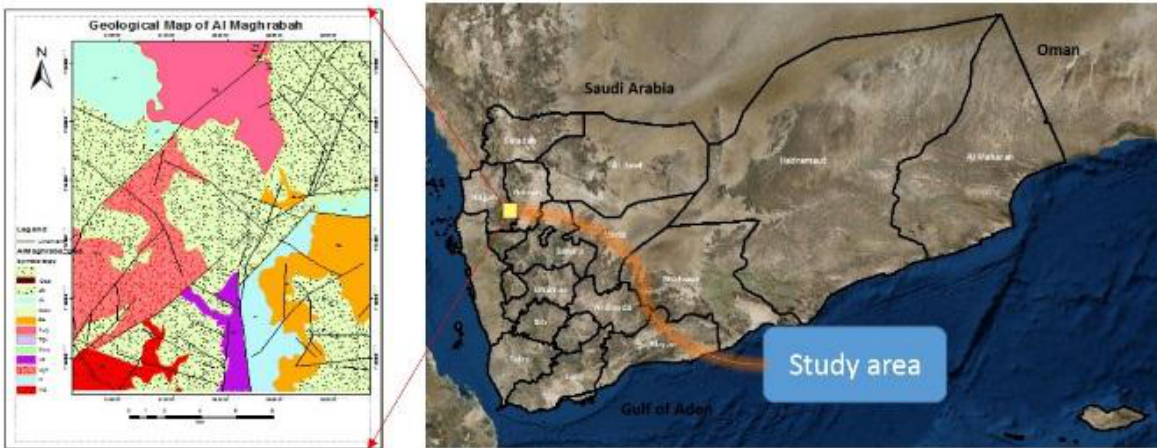
Figure 2. Map of Yemen showing the Location of the area study